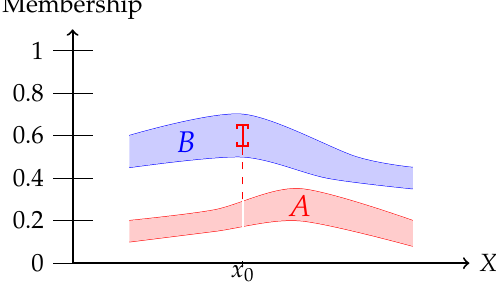
Figure 17. A and B are not comparable due to a single element x 0